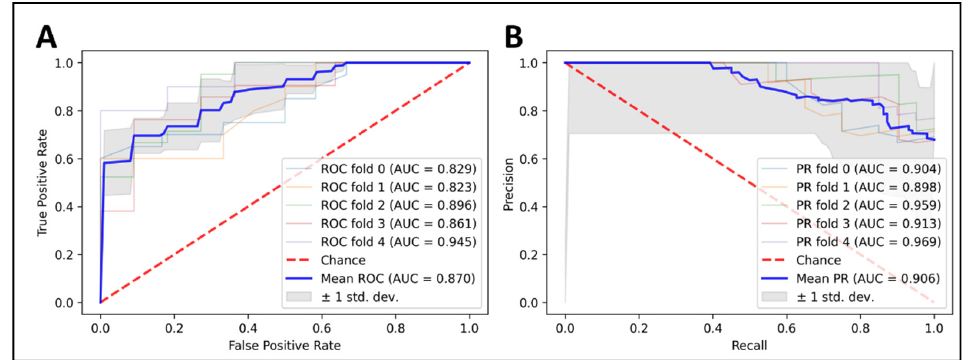
Figure 3. Predicting 1p/19q status using XGBoost classifier on top seven radiomics features. Cross- validation is implemented to get see the model consistency. ( A ) ROC curve analysis (AUC = 0.87), ( B ) PRC curve analysis (AUC = 0.906).